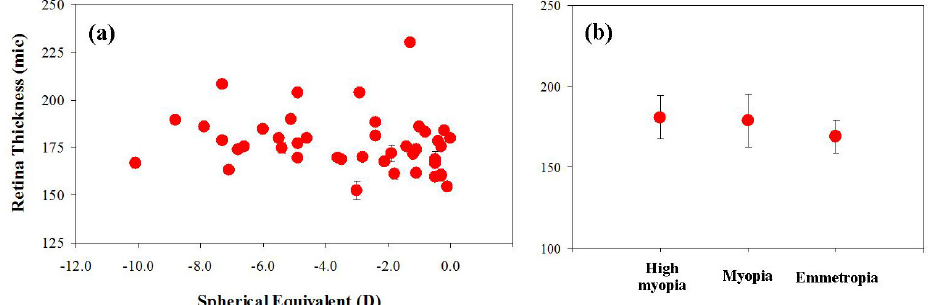
Figure 4. ( a ) Retinal thickness at the foveal location as a function of the ocular refraction. ( b ) Averaged retinal thickness for each myopia group. Error bars in both panels represent the standard deviation. In some cases (left panel), the size of the error bars are within the red symbols.